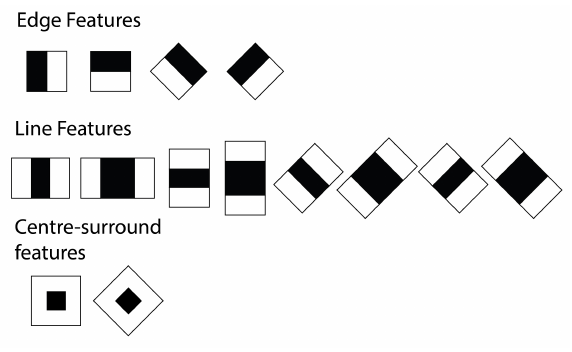
Figure 10. Total set of features used by the OpenCV detection.